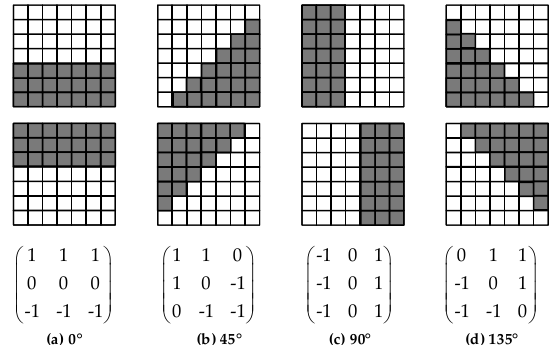
Figure 2. The detection template and edge direction window of the refined lee filter. (a) 0°; (b) 45°; (c) 90°; (d) 135°.